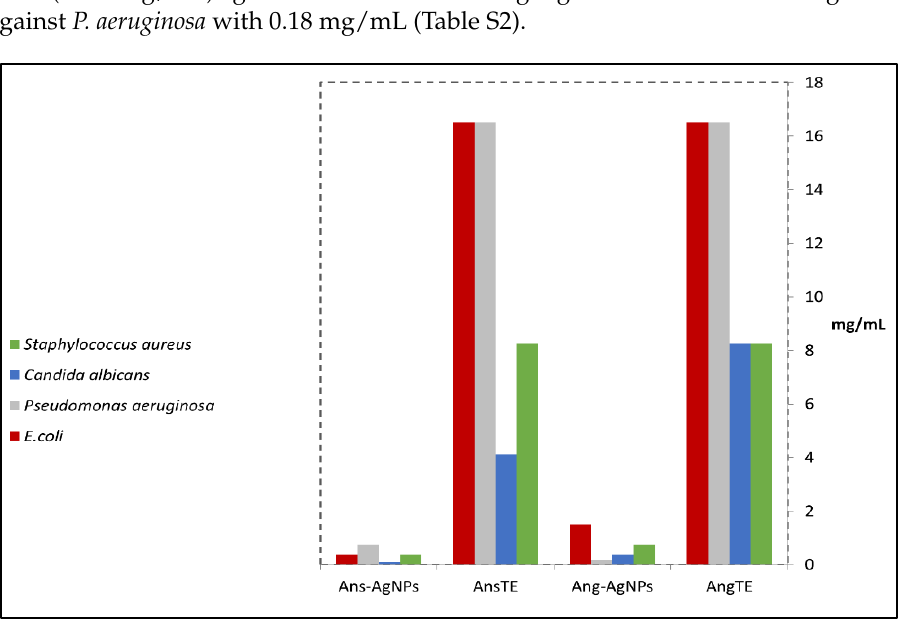
Figure 7. Results of the minimum inhibitory concentration (MIC) of the extracts, AngTE and AnsTE and their corresponding biogenic silver nanoparticles, Ans-AgNPs and Ang-AgNPs towards P. aeruginosa , E. coli , and C. albicans . Table 1. Synergistic activity of Ans-AgNPs (4B/FM) and gentamicin against the bacterial species .